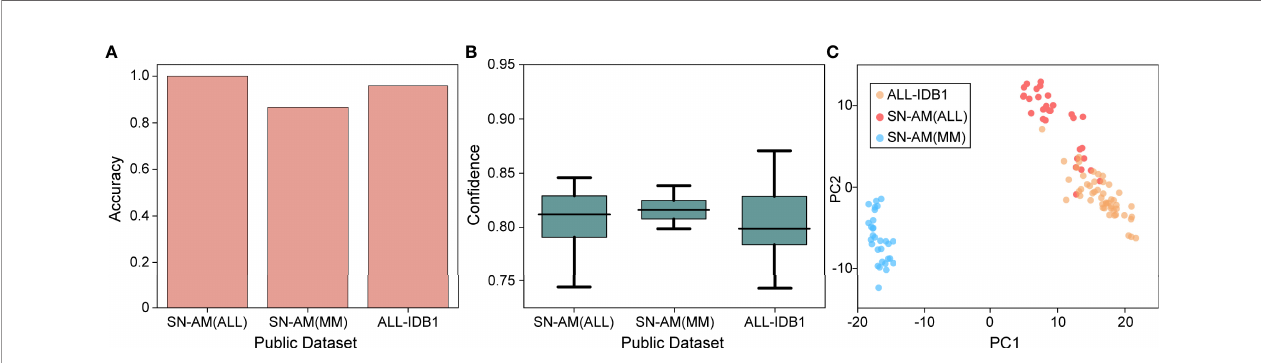
FIGURE 5 | Performance on microscopy images. (A) Mean accuracy on the public dataset (SN-ALL, SN-MM, and ALL-IDB1) test on 40× magni fi cations with a single cross-validated fold. (B) Con fi dence ( ± 1 s.d.) of the prediction made by the model. (C) Slide-level feature space for a single cross-validated fold using PCA in the validation and test sets.